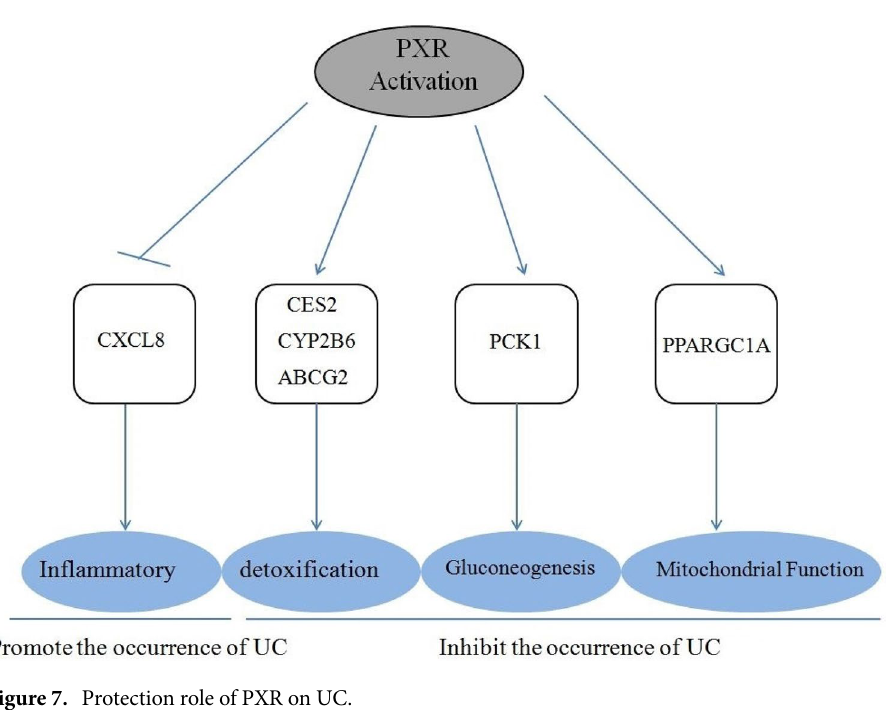
Figure 7. Protection role of PXR on